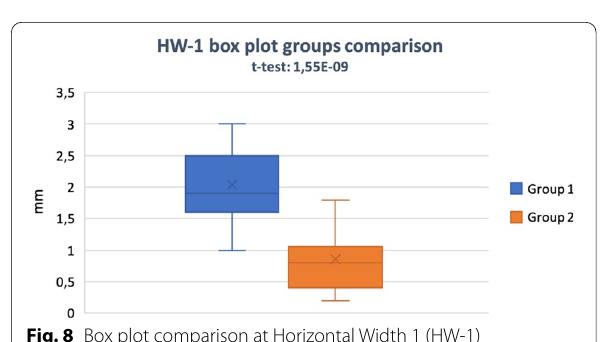
Fig. 8 Box plot comparison at Horizontal Width 1 (HW-1)